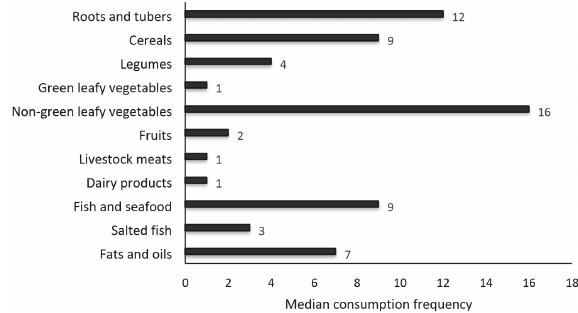
Figure 1: Respondents’ median frequency of consuming foods from different food groups in the past seven days.